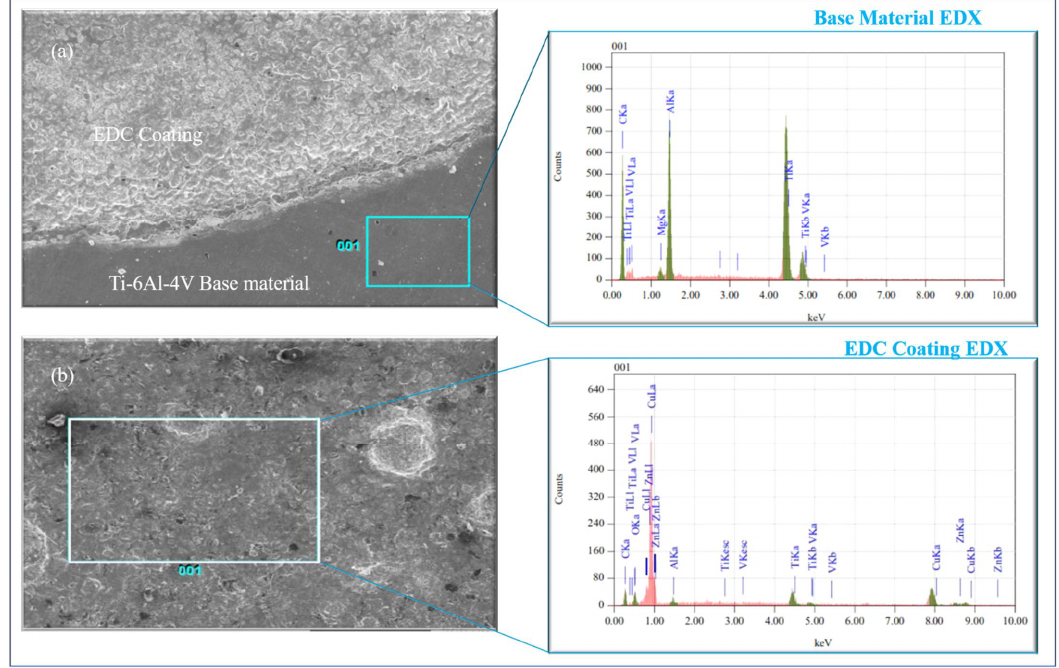
Figure 6. EDX comparison, ( a ) Base material Ti-6Al-4V, EDX, and ( b ) EDC coating EDX.